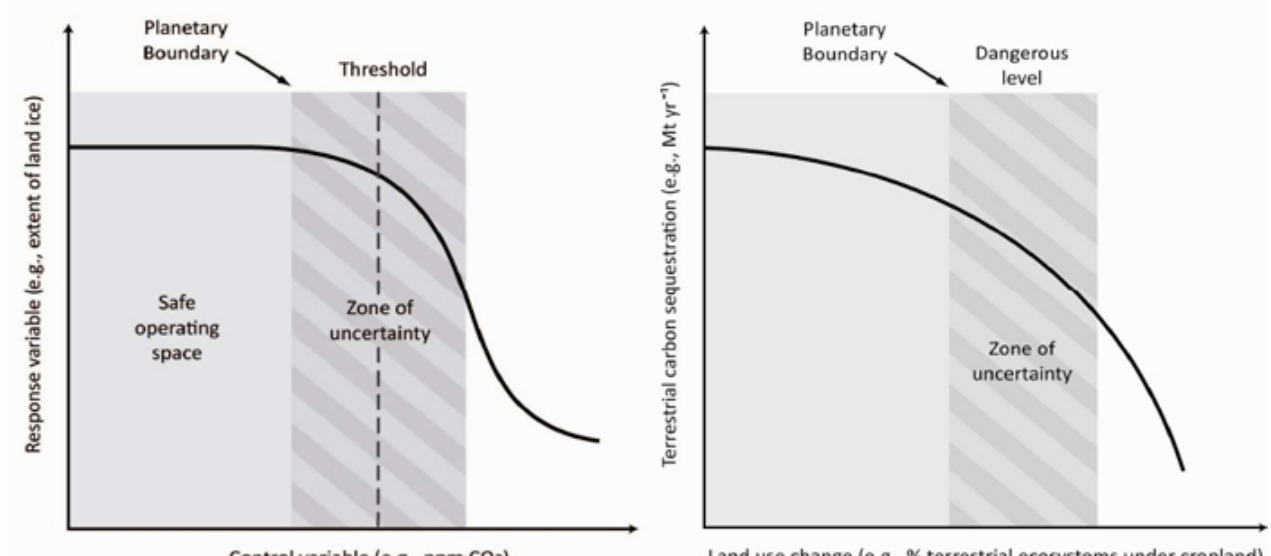
Fig. 2. Conceptual description of planetary boundaries. In (a) the boundary is designed to avoid the crossing of a critical continental to global threshold in an Earth System process. Insufficient knowledge and the dynamic nature of the threshold generate a zone of uncertainty about its precise position, which informs the determination of where to place the boundary. In (b) there is no global threshold effect as far as we know, but exceeding the boundary level will lead to significant interactions with regional and global thresholds and/or may cause a large number of undesired threshold effects at the local to regional scale, which in aggregate add up to a serious global concern for